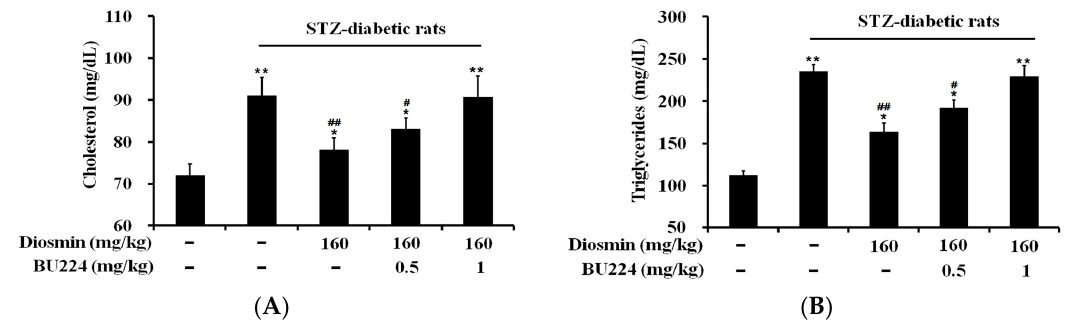
Figure 5. Effects of diosmin on the plasma lipid level was reduced by the blockade of I-2 receptors using an antagonist. Plasma cholesterol ( A ) and triglyceride ( B ) levels shown in the 1st column, which was elevated in diabetic rats (2nd column), was inhibited by diosmin, as shown in the 3rd column, and this effect was dose-dependently reversed by the blockade of I-2R using the antagonist BU224 (column 4th and 5th). The values are presented as mean ± SEM ( n = 8). * p < 0.05 and ** p < 0.01 compared with the indicated basal value in vehicle-treated normal rats as shown in the 1st column. # p < 0.05 and ## p < 0.01 compared with the value resulting from the treatment with diosmin (3rd column) only.